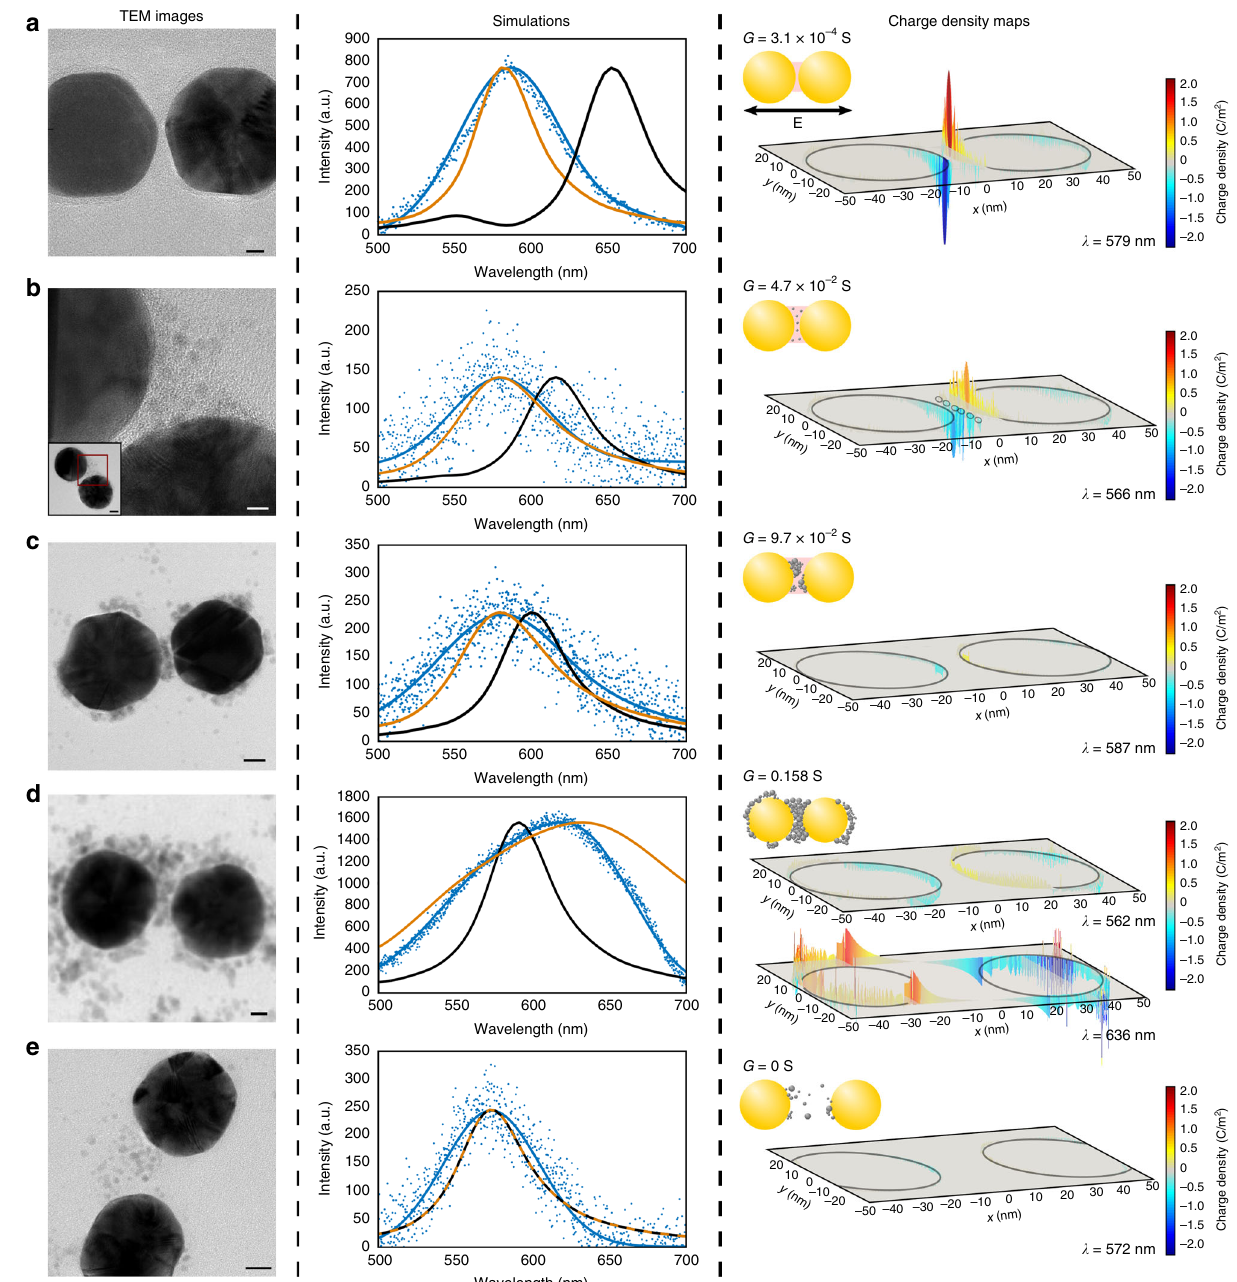
Fig. 4 Correlated spectroscopy and TEM analysis of Pd NP containing PRs. a Gap width, S = 2.0 nm; experimental peak wavelength (blue), λ exp = 586nm; peak wavelength of the FDTD simulated spectrum (black), λ sim = 651 nm; peak wavelength of the corrected FDTD simulations (orange), λ corr = 580 nm. Scale bar = 5 nm. b S = 4.0 nm; λ exp = 575 nm; λ sim = 612 nm; λ corr = 566 nm. Scale bar = 5 nm. c S = 5.6 nm; λ exp = 580 nm; λ sim = 599 nm; λ corr = 578 nm. Scale bar = 10 nm. d S = 8.3 nm; λ exp = 621 nm (shoulder λ exp = 569 nm); λ sim = 590 nm; λ corr = 632 nm (shoulder λ corr = 562 nm). Scale bar = 10 nm. e S = 18.0 nm; λ exp = 573 nm; λ sim = 572 nm; λ corr = 572 nm. Scale bar = 10 separations a moderate gap conductance mediated either by DNA DNA-mediated gap conductance 30,43 . Indeed, the corrected or discrete contacts established by Pd NPs accounts for a FDTD simulations that account for DNA-mediated gap con- signi fi cant spectral blue-shift. ductance yield a peak resonance wavelength of λ corr = 580 nm and successfully reproduces the experimental spectrum for the The PR in Fig. 4b has a longer gap separation of S = 4.0 nm, dimer in Fig. 4a. The PR with short interparticle separation in and the TEM shows individual Pd NPs interspersed in the gap. Fig. 4a does not contain a Pd NP in the gap. For completeness we Although the Pd NPs do not establish a continuous metallic add that an increase in gap conductance due to an interstitial Pd connection between the two Au NPs, and the interparticle NP that touches both Au NPs and forms a conductive bridge separation is signi fi cantly longer than S thresh , the BDP resonance is still remarkably blue-shifted ( λ exp = 575 nm) when compared between the Au NPs provides a very similar spectrum to the classical electromagnetic prediction ( λ sim = 615 nm). S is (Supplementary Fig. 7). Consequently, at very short interparticle